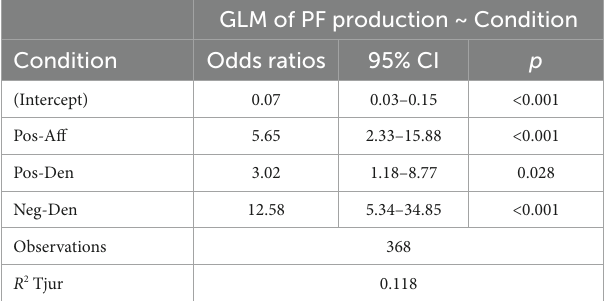
TABLE 1 Summary of GLM with PF production as a binominal response analyzed as a function of